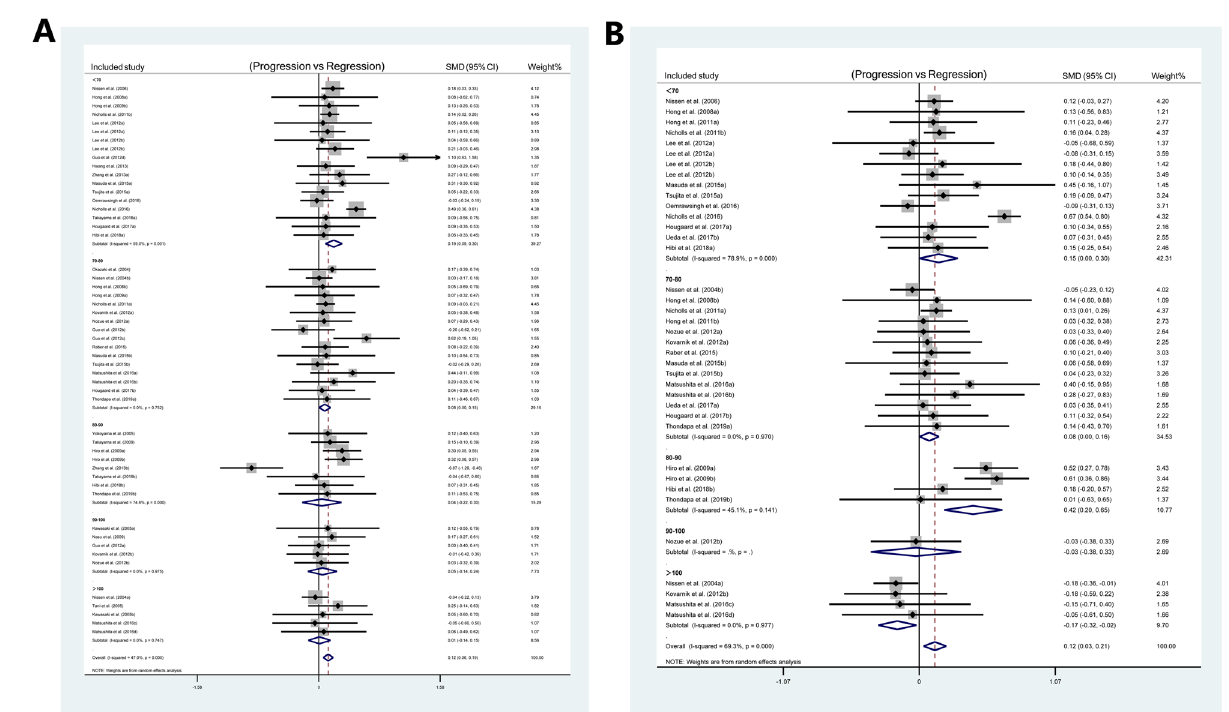
Figure 1. Subgroup analysis for SMD in plaque volume between patients at baseline and follow-up: ( A ) subgroup analysis of TAV according to the different levels of LDL; ( B ) subgroup analyses of PAV according to the different levels of